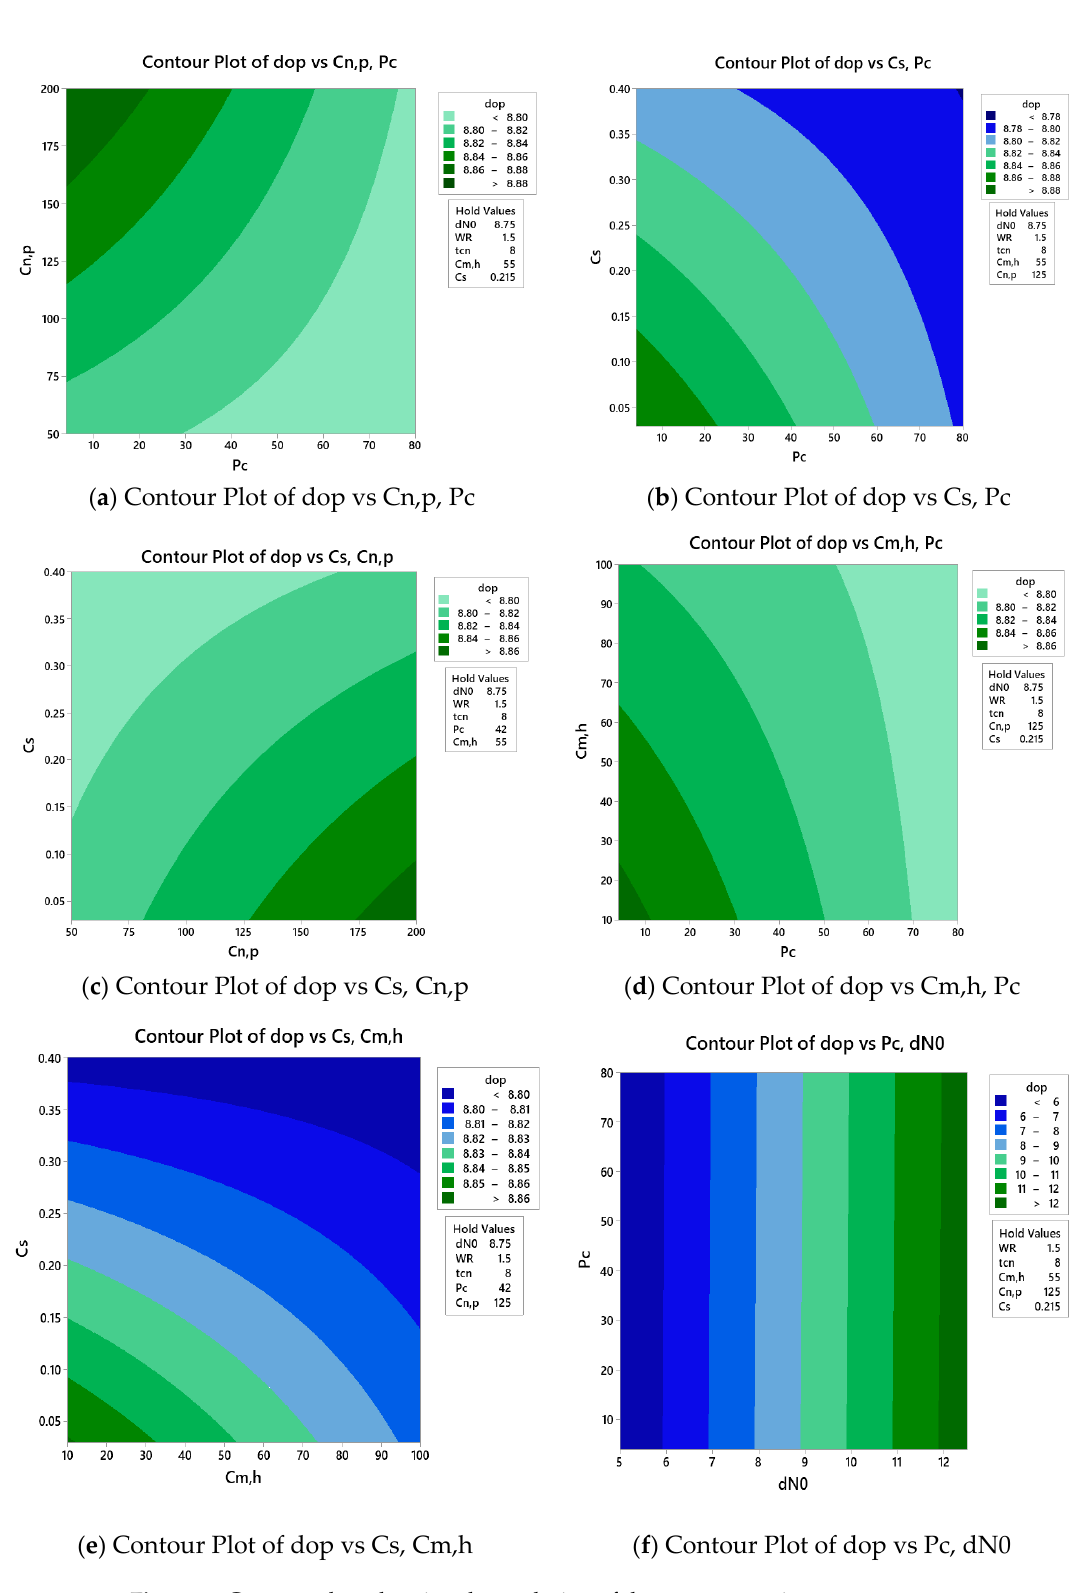
( e ) Contour Plot of dop vs Cs, Cm,h ( f ) Contour Plot of dop vs Pc, dN0 Figure 8. Contour plots showing the evolution of the response vs input parameters. Figure 8. Contour plots showing the evolution of the response vs input